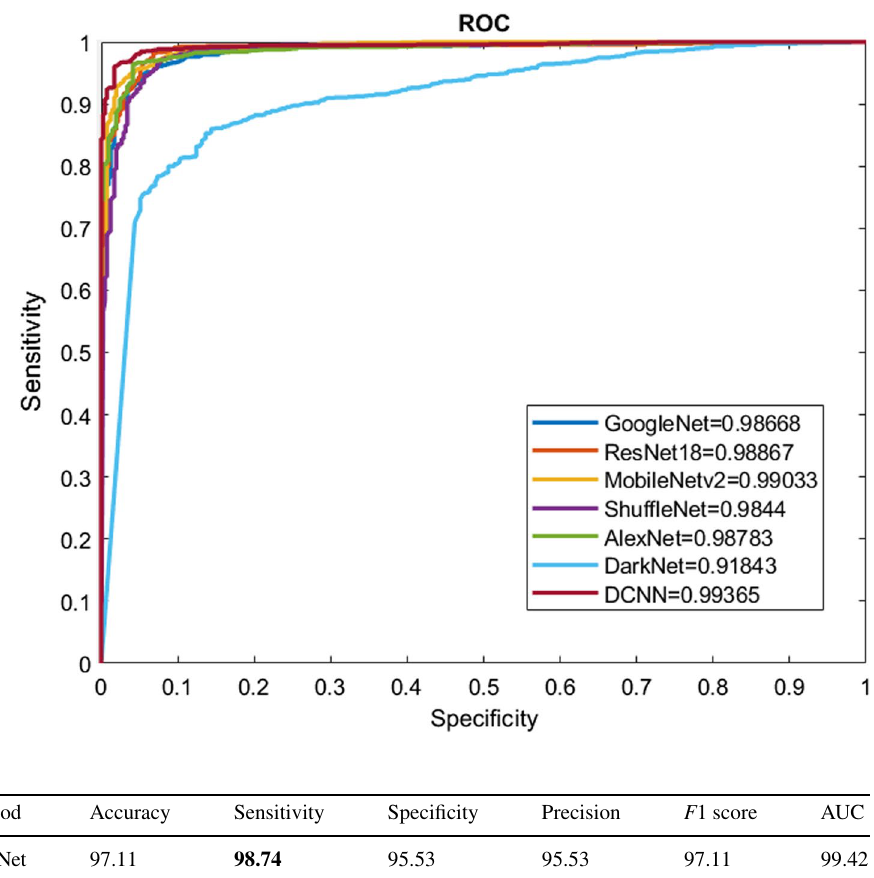
Fig. 6 ROC curves of CNN architectures